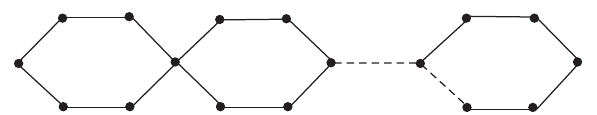
Figure 3: Example of the paracactus chain graph of cycles for m � 6 and n � n